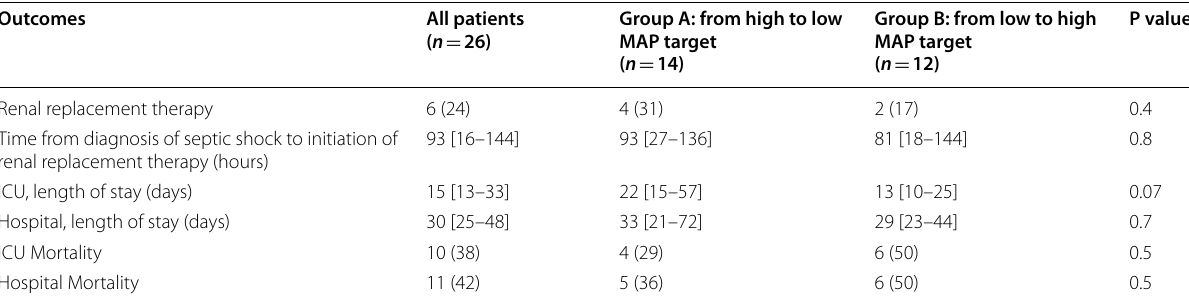
Table 2 Patient outcomes